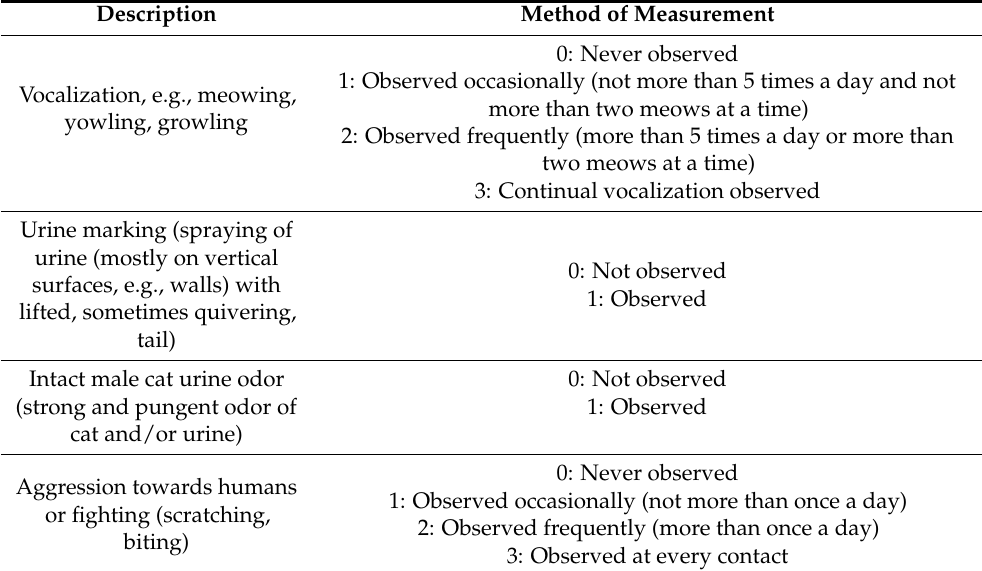
Table 1. Scoring system used to describe the different sexual behaviors. The total combined sexual behavior score corresponds to the sum score of individual behaviors at every time point and is rated from 0 to